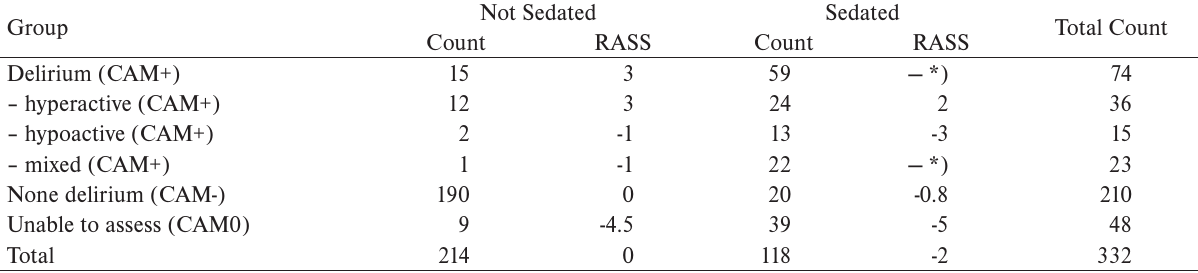
Table 1. The number of patients and RASS median in the groups by delirium occurrence and sub-type, and by sedation. Not Sedated Sedated Group Delirium